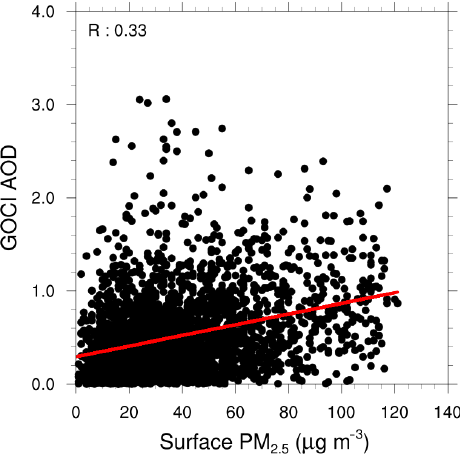
Figure 5. Scatter plots of GOCI AOD retrievals versus ground PM 2 . 5 observations collocated in domain 1 for the month of May 2016. The value of R is the correlation coefficient between the two observation types based on the linear regression shown as the red line.